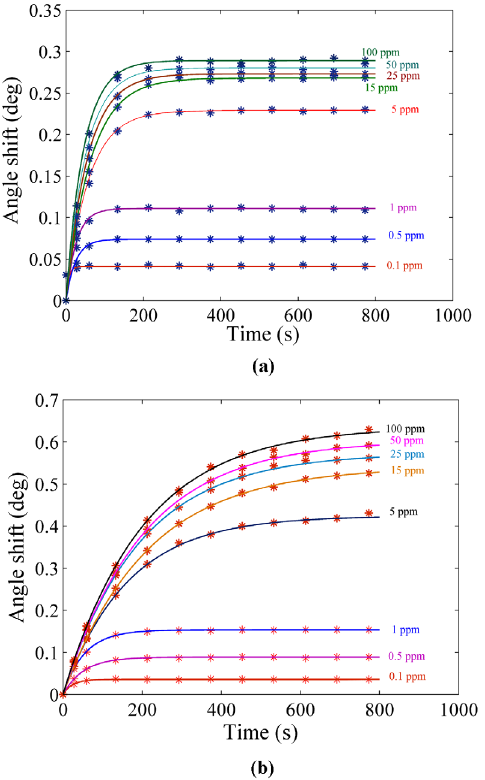
Figure 6. Sensogram for each concentration of the Hg ions: a) PPy sensing layer b) PPy-MWCNTs.